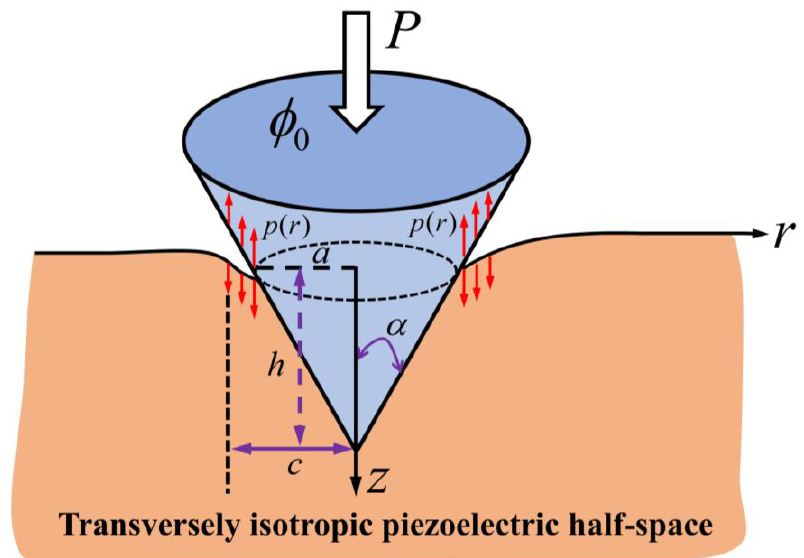
Figure 1. Schematic illustration of a piezoelectric solid in adhesive contact with a rigid conical punch under a normal force, P (negative when tensile). φ 0 denotes the constant electric potential; a , h , α , and p ( r ) stand for the contact radius, the indentation depth, the half cone angle of the rigid conical punch, and the adhesion force, respectively. The poling direction of the piezoelectric solid corresponds with the positive z -axis.